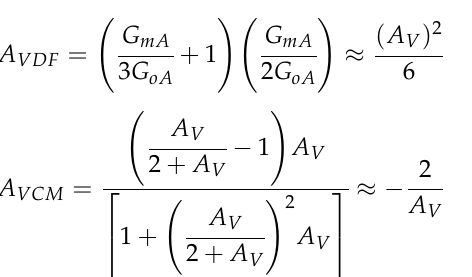
Figure 13. Nauta/Vieru (N/V) hybrid OTA circuit diagram. For A = 2 B = 2 C = G , 2 E = F , and 2 A = D =